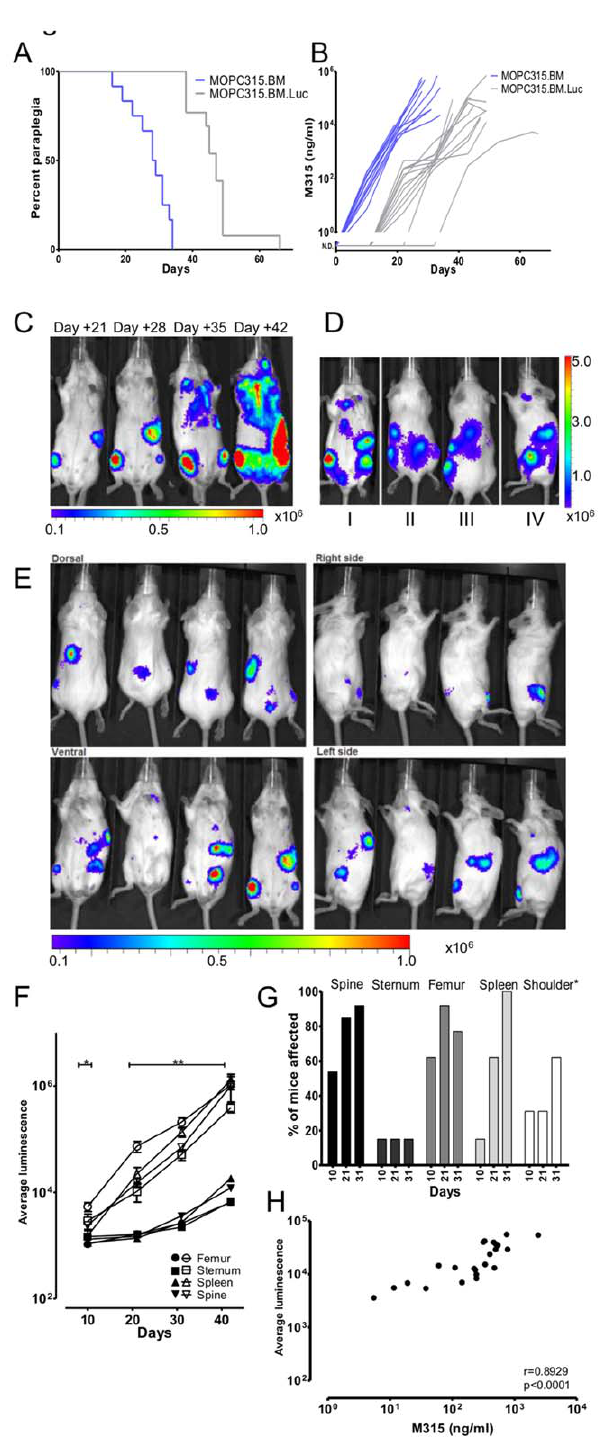
Figure 2. Delayed growth and BLI of Luciferase-transfected MOPC315.BM-cells. (A) Tumor take experiment with MOPC315.BM.- Luc (2 6 10 5 cells i.v.) (n=13) was overlaid that of MOPC315.BM shown in Fig. 1B (also 2 6 10 5 cells i.v.). The survival curves showing development of paraplegia are significantly different (p , 0.0001). (B) Levels of M315 myeloma protein in sera of mice in (A). M315 was significantly different at day 10, 20 and 30 (p , 0.002). N.D.=Not Detected. (C–E) All scales in photons/second/cm 2 /steradian. (C) Timeline of bioluminescent signals in a representative BALB/c mouse injected with 2.0 6 10 5 MOPC315.BM.- Luc i.v. (D) Examples of typical sites of affection. I: sternum,